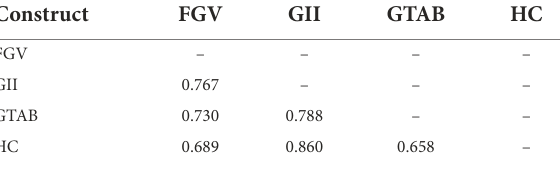
TABLE 5 Hypotheses